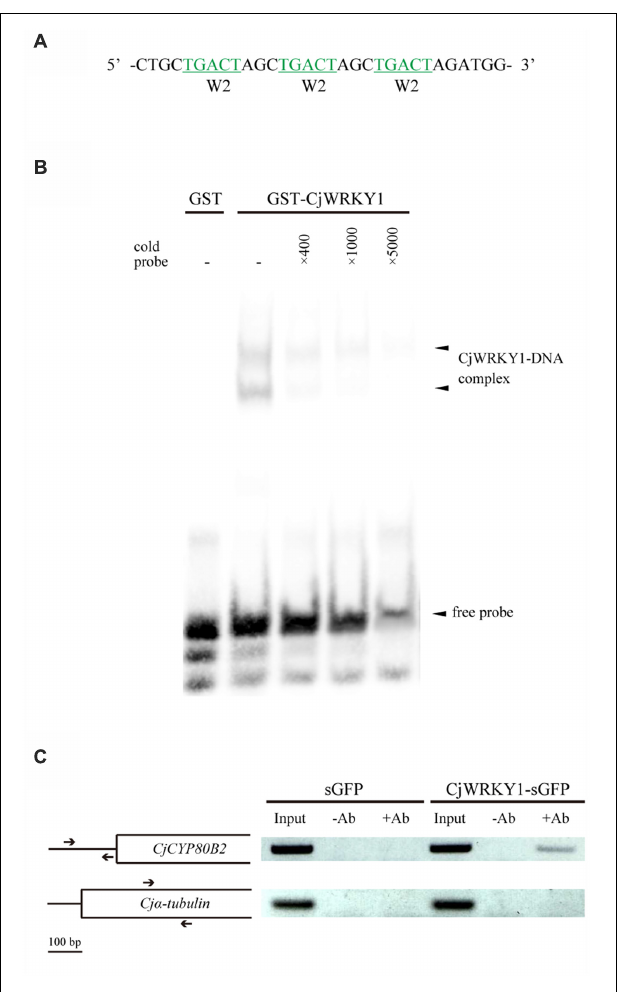
FIGURE 6 | The binding activity of CjWRKY1 to the CYP80B2 promoter. (A) The oligonucleotide sequence used for the EMSA contains three repeats of W-box sequences (TGACT). (B) The in vitro binding activity of CjWRKY1 protein to the W-box DNA sequence motif was confirmed by EMSA analysis. EMSA was carried out with a purified GST-CjWRKY1 recombinant protein and a biotin-labeled probe. Arrows indicate the shifted bands corresponding to the protein-DNA complexes. (C) CjWRKY1 directly binds to the CYP80B2 promoter region in vivo . A ChIP assay was performed with anti-GFP antibodies. The left panel indicates the structure of the coding region of the CYP80B2 and the α -tubulin genes. Arrows indicate specific primer pairs used for PCR. The right panel shows PCR products from immunoprecipitated chromatin and input controls incubated without ( − Ab) or with ( + Ab) anti-GFP antibodies before